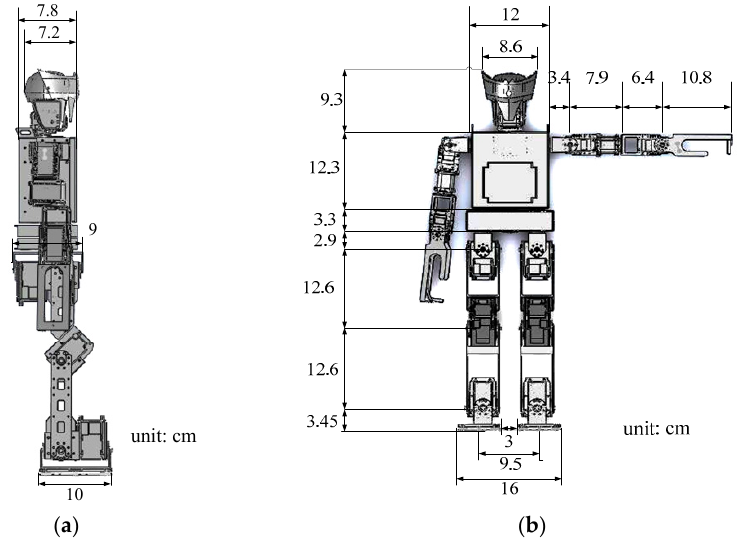
Figure 2. Mechanism and dimensions of the small-sized humanoid robot: ( a ) sagittal plane; ( b ) frontal